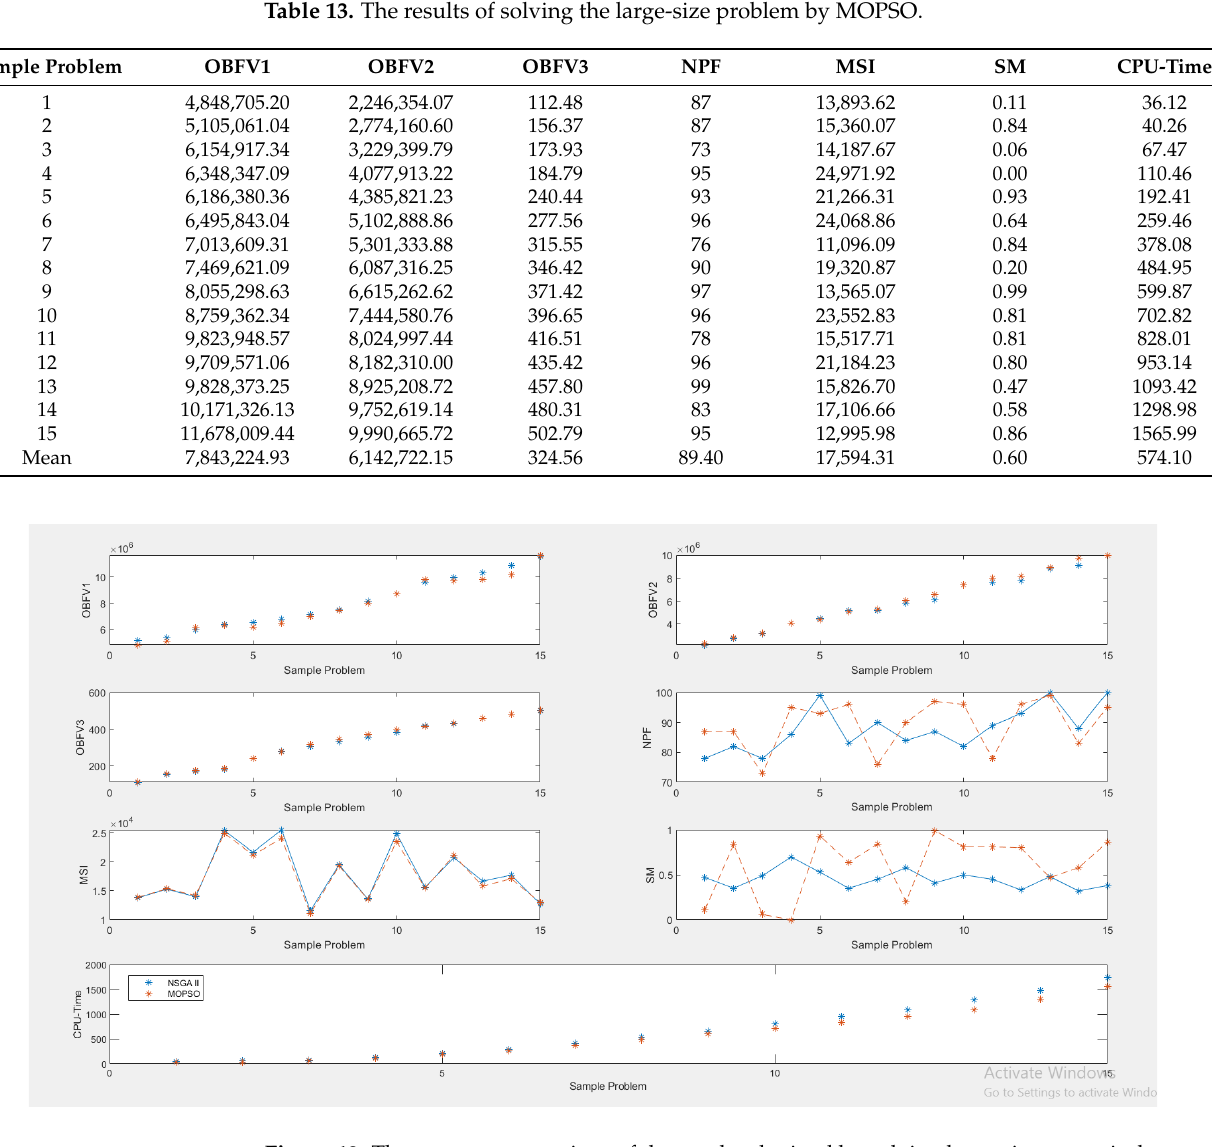
Figure 12. The average comparison of the results obtained by solving large-size numerical examples.